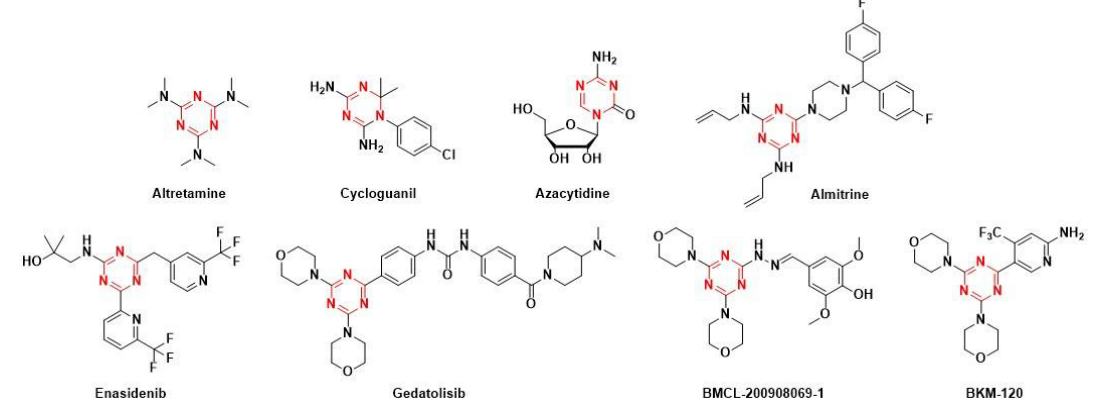
Figure 1. 1,3,5-Triazine containing drugs in market and derivatives in phase Ⅲ clinical trials.